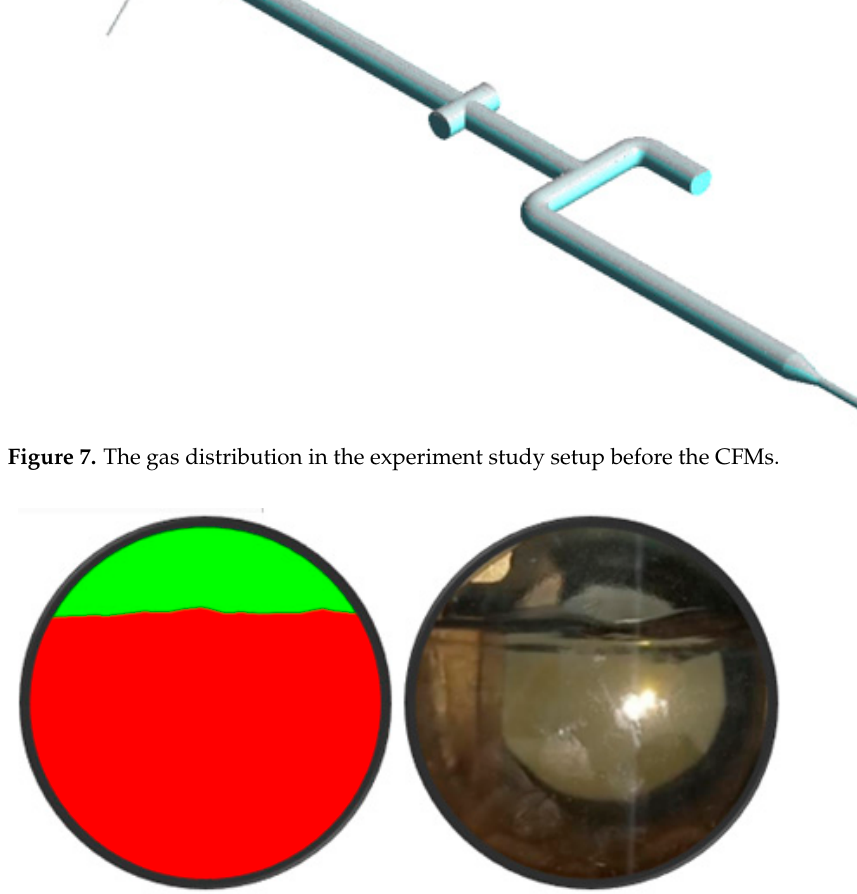
Table 3. The investigated flow conditions for the validation of bubbly flow regime [47]. Mixture Flow Rate, kg/s